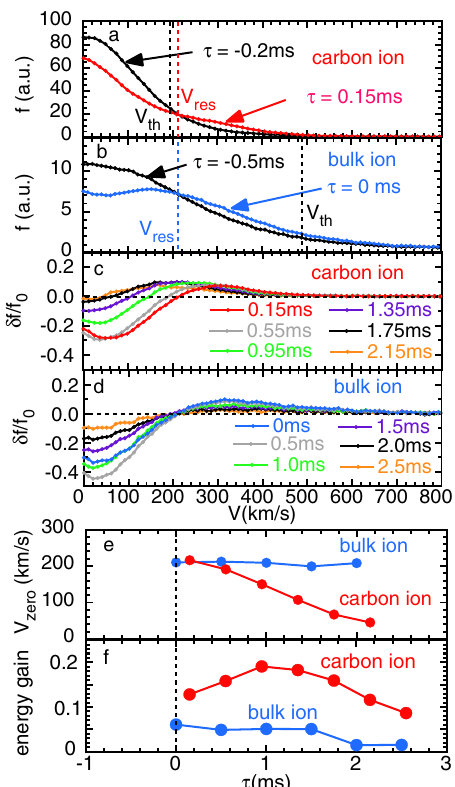
Fig. 6 Energy gain of carbon impurity ions and bulk ions after the transit- time damping. Distribution function of ion velocity at r eff / a 99 = 0.79, before (black circles and lines) and at the onset of solitary wave (red and blue circles and lines) for a carbon impurity ions and for b bulk ion and the difference of velocity distribution function before and 0.15 ms (red), 0.55 ms (gray), 0.95 ms (green), 1.35 ms (purple), 1.75 ms (black), 2.15 ms (orange) after the onset of solitary wave for c carbon impurity ions and 0 ms (blue), 0.5 ms (gray), 1.0 ms (green), 1.5 ms (purple), 2.0 ms (black), 2.5 ms (orange) after the onset of solitary wave for d bulk ions. The time evolution of e zero-cross velocity and f energy gain ( M 2 M 0 ) of bulk ions (blue circles) and carbon impurity ions (red circles). The error bars in e and f are uncertainties attributed to an evaluation of zero-cross velocity and integration of bipolar signature, respectively, and they are smaller than the symbols. (#175095, #175097, #175104, #175364,